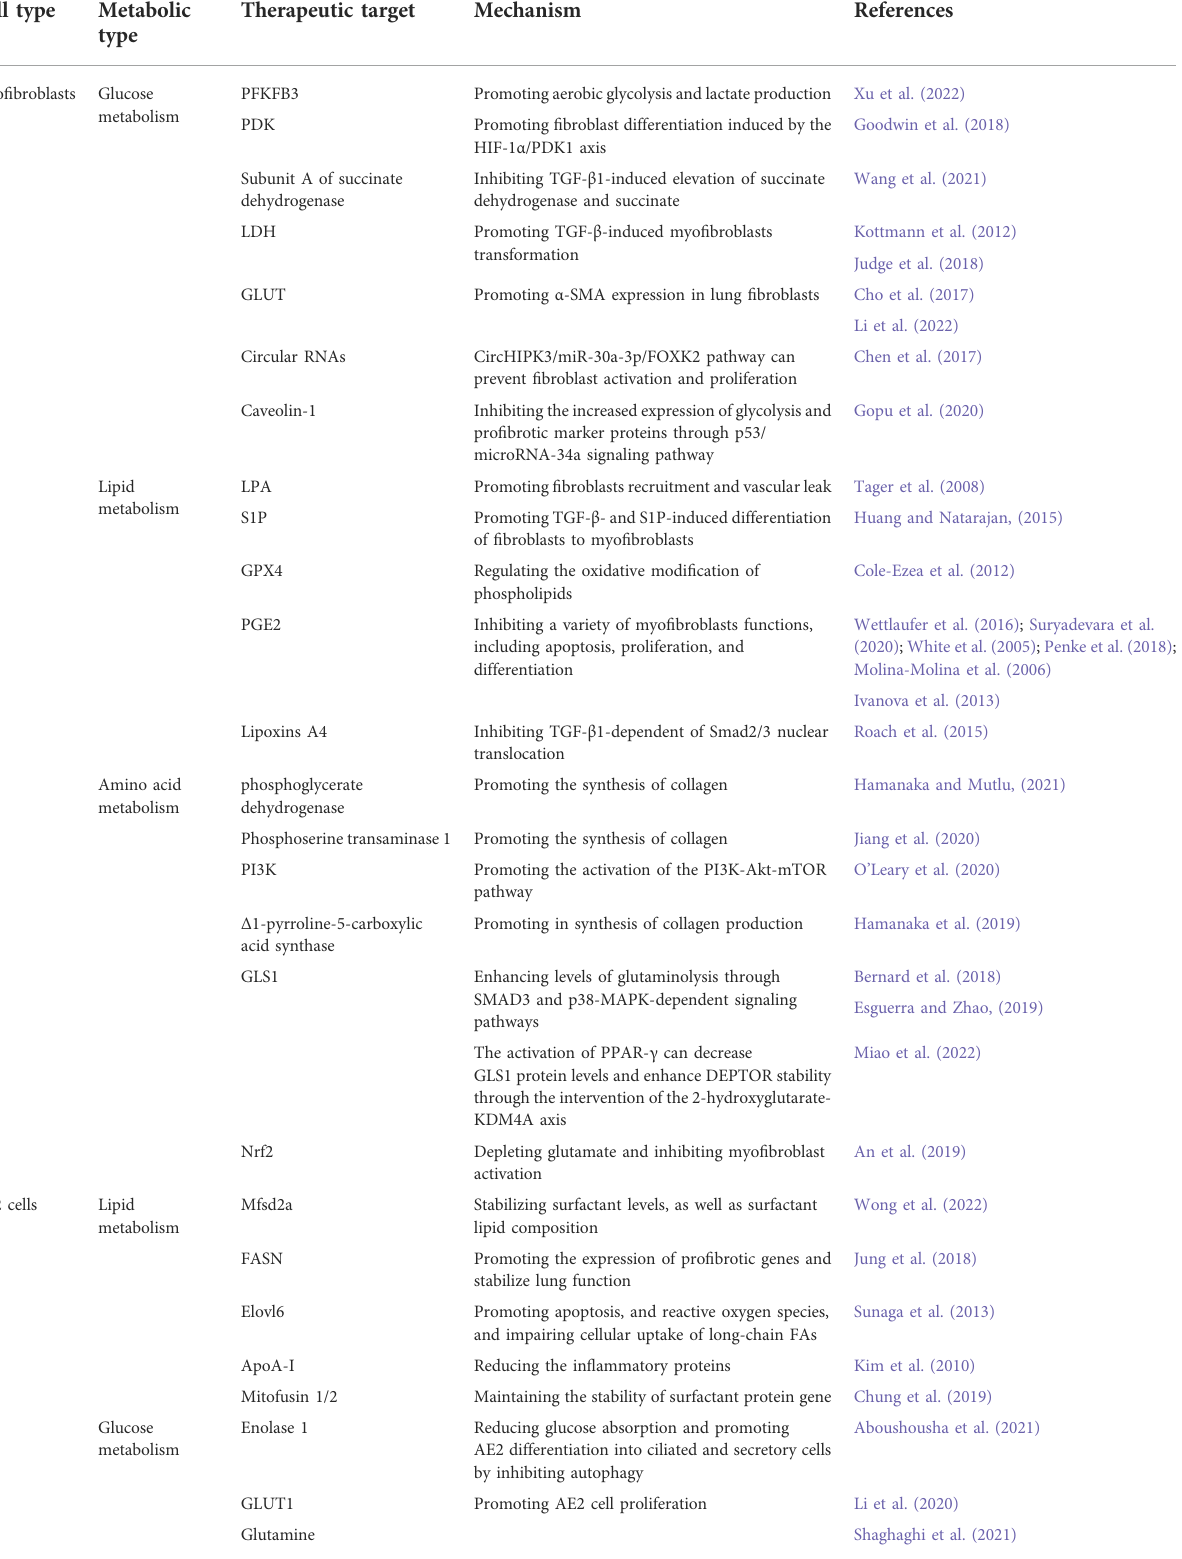
TABLE 2 Overview of therapeutic targets and related mechanisms in pulmonary fi